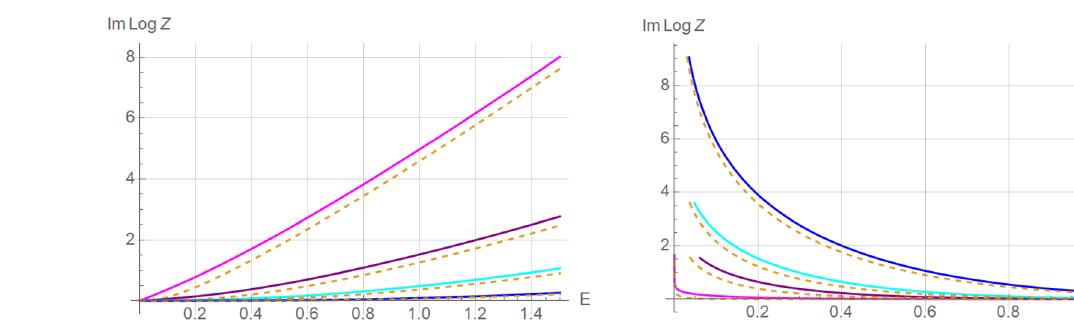
Figure 9. The non-persistence of the vacuum in the spinor case, as function of electric field E and mass m . The solid lines are (4.9). The dashed ones are (4.12). The non-thermal result is always closer to the flat space one. Note that unlike the scalar case, both spinor results are monotonic. Moreover, the imaginary part blows up as the mass goes to zero. For the scalar, this limit is